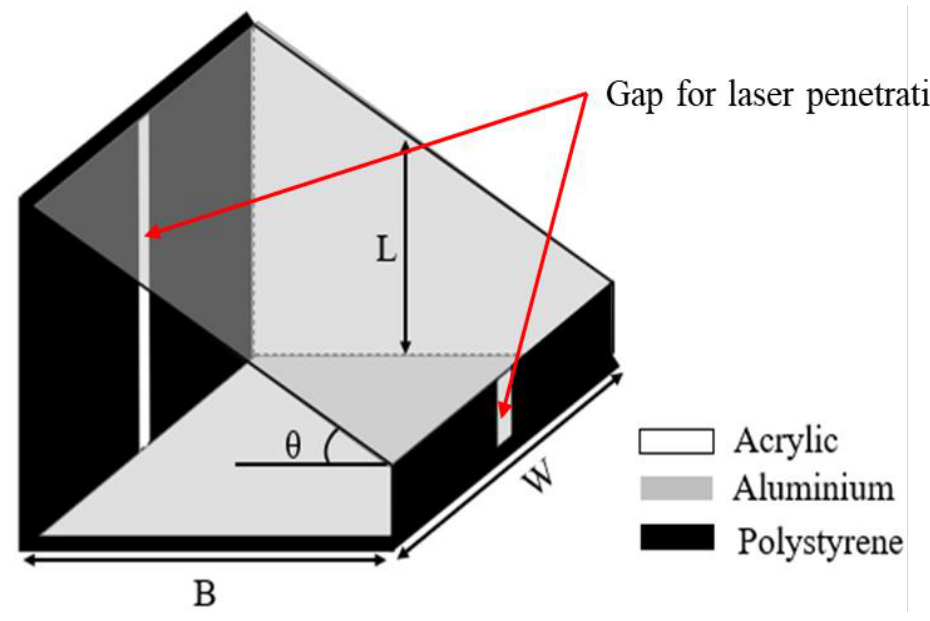
Figure 5. Schematic representation of experimental enclosure. In fabricating the experiment, the back, front, and side walls of the still enclosure were made of transparent acrylic sheets to allow optical access. The front and back walls were insulated by a polystyrene sheet of 4 cm thickness, with a small gap was left to allow the laser sheet penetration in the cavity. However, the side walls were not insulated as optical access for the camera used in the PIV needed to be maintained. Both the cover and bottom surfaces were made from aluminum sheets of 3 mm thickness to ensure a uniform temperature distribution (and structural integrity) and were coated with black paint to avoid laser reflection.